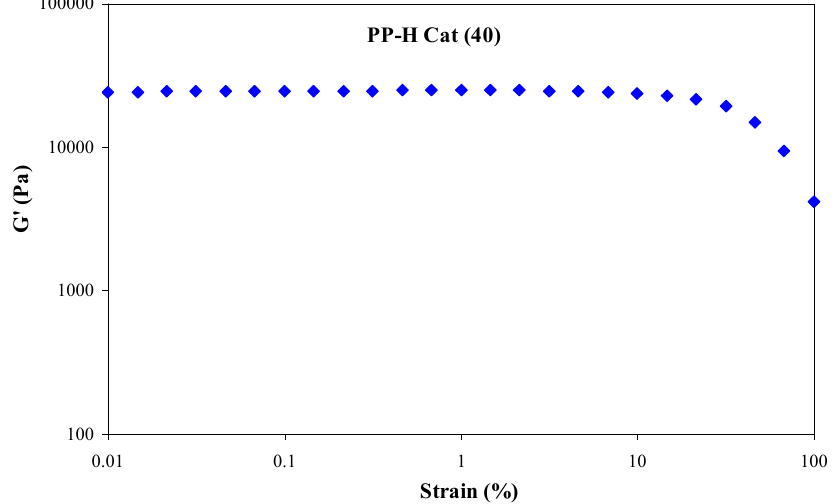
Figure 3. Storage modulus versus strain amplitude at a constant frequency of 10 rad/s and temperature of 200 °C